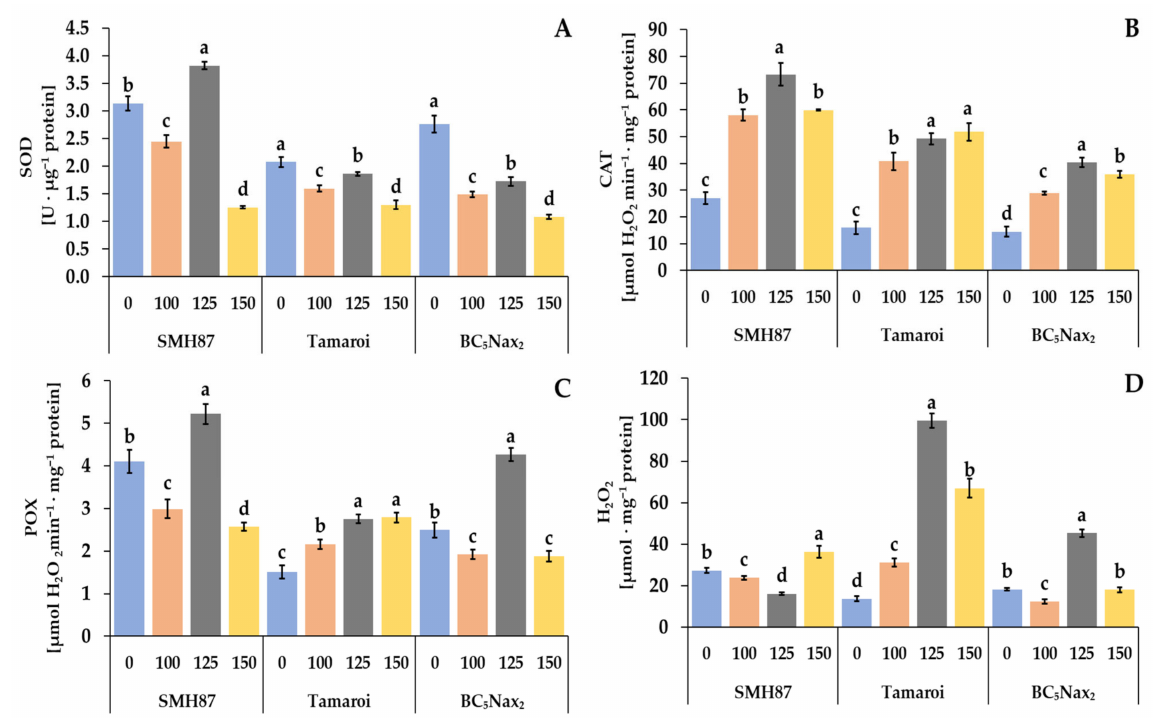
Figure 6. Effects of NaCl treatments (0, 100, 125, 150 mM) on SOD—superoxide dismutase ( A ), CAT—catalase ( B ), POX—peroxidase ( C ) activity, and H 2 O 2 —hydrogen peroxide ( D ) content. The values represent means (n = 3) ± SE within each accession, and those marked with the same letters do not differ statistically according to multiple range Duncan’s test ( p <